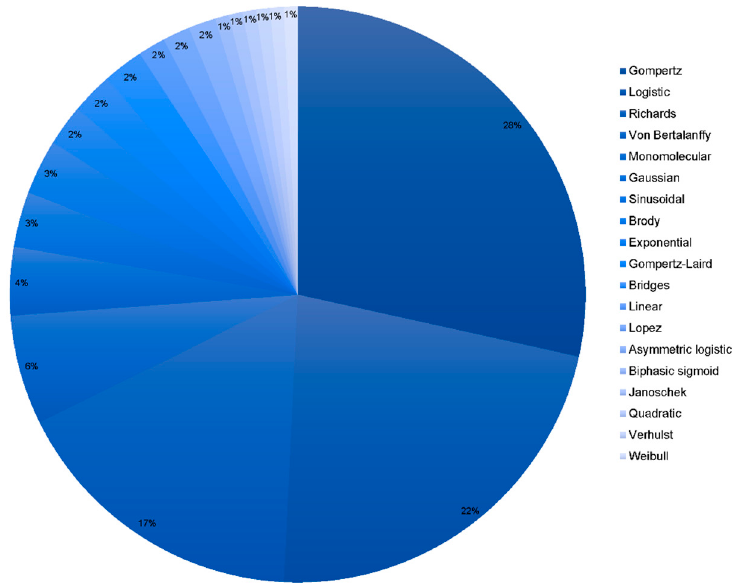
Figure 2. Frequency analysis of the models used to fit for growth and performance in native breeds. The darker the blue in the cheese graphic, the most frequently the model was used. The model in legend appears in decreasing frequency order.